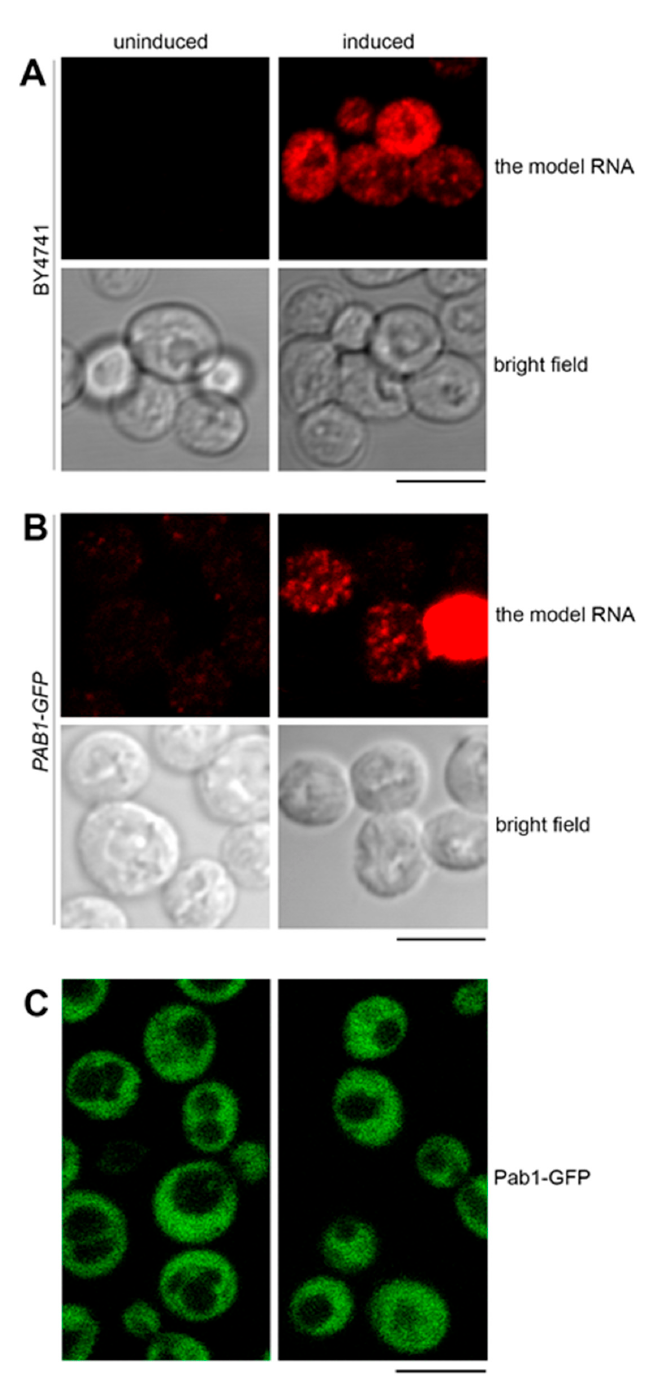
Figure 4. The model RNA is located to cytoplasmic granules distinct from stress granules. ( A ) and ( B ): Expression of the model RNA was visualized by FISH in wild-type (BY4741) ( A ) and in PAB1-GFP ( B ) strains and showed a similar pattern of cytoplasmic granules formed in approximately 50% of cells. ( C ): Live-cell imaging of PAB1-GFP strain expressing the model RNA did not detect formation of stress granules. In all panels, the model RNA was expressed as in Figure 2, and uninduced cells were used to control for unspecific FISH signal ( A ) and ( B ) and for appearance of stress granules unrelated to the expression of the model RNA (C). Scale bar is 5 µm.